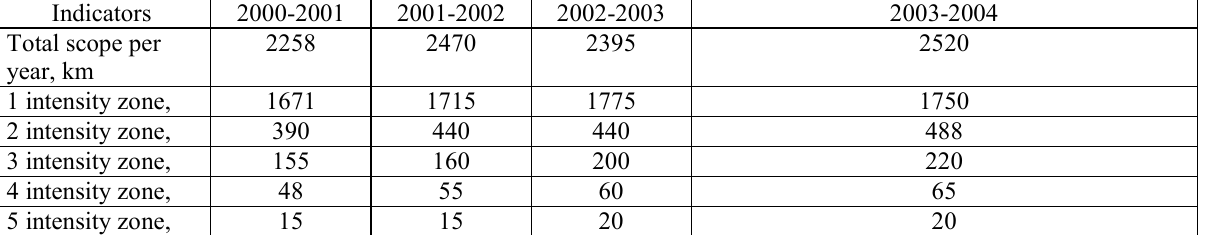
Total scope and intensity in % from “max” of Ya.